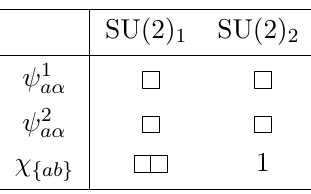
Table 1 . The matter content of the gauge theory near the conformal